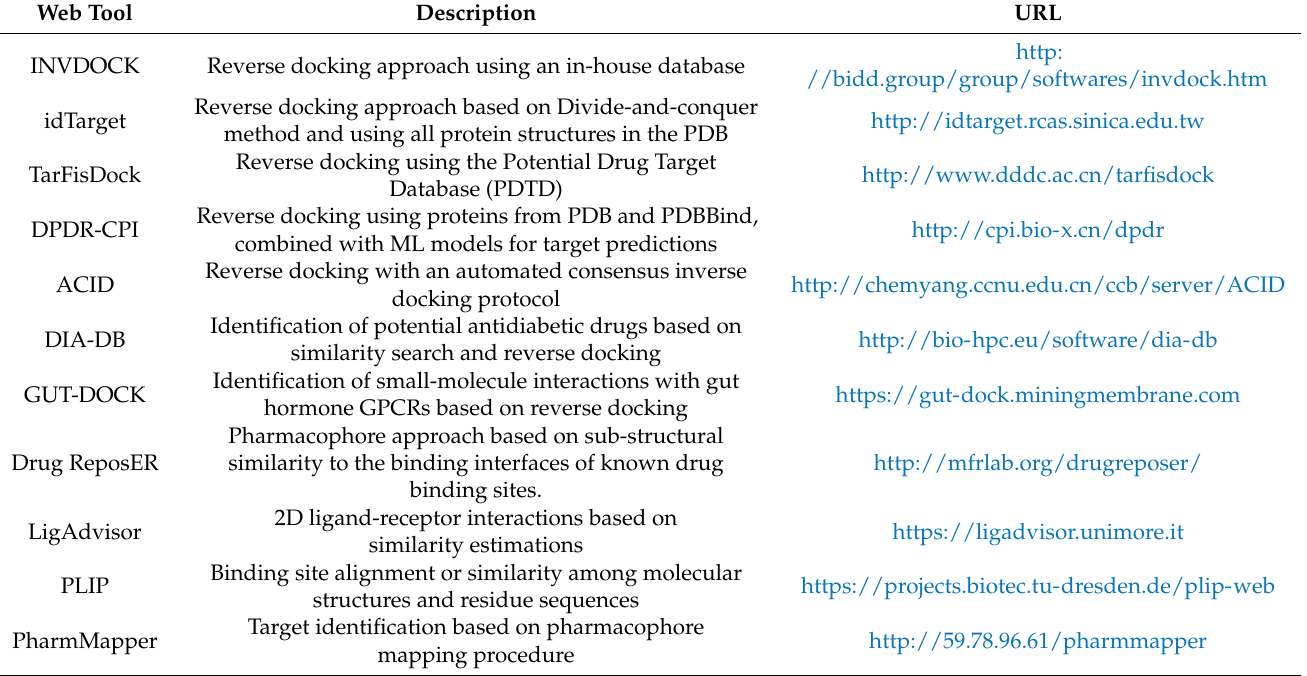
Table 2. Summary of the different receptor-based web tools further discussed in the review (access date: 1 June 2021). Web